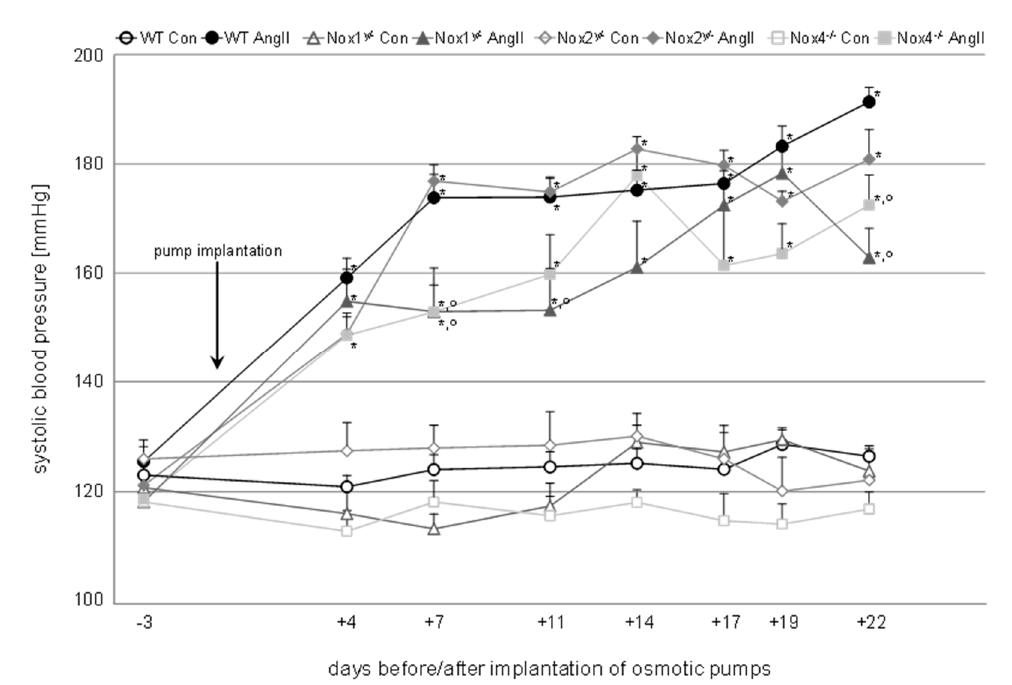
Figure 1. Time course of systolic blood pressure measured in wildtype and knockout animals of the control (Con) and angiotensin II-treated (AngII) groups. Blood pressure was measured at eight time points after habituation to the measurement procedure. The first time point represents the initial systolic blood pressure of the animals before implantation of the osmotic minipumps. After the implantation, blood pressure was measured twice a week. Data are shown as mean + SEM. * p ≤ 0.01 vs. the respective control, and ° p < 0.05 vs. angiotensin II-treated WT animals analyzed by one-way ANOVA. WT, wildtype; Con, control; AngII, angiotensin II; Nox, NADPH oxidase catalytic subunit.